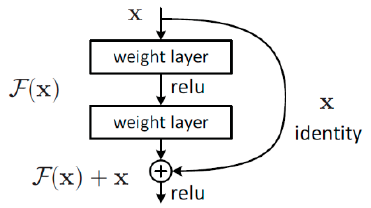
Figure 1. The structure of the residual block [33].